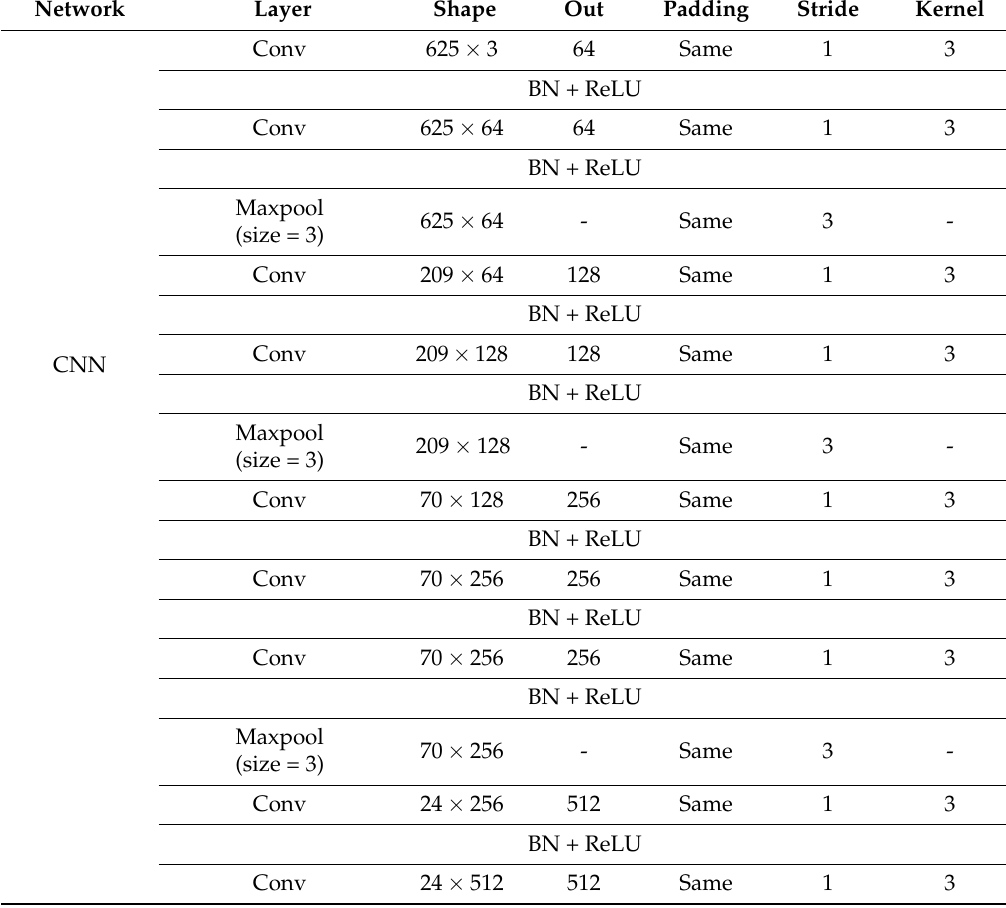
Table 2. Detailed structure of the proposed